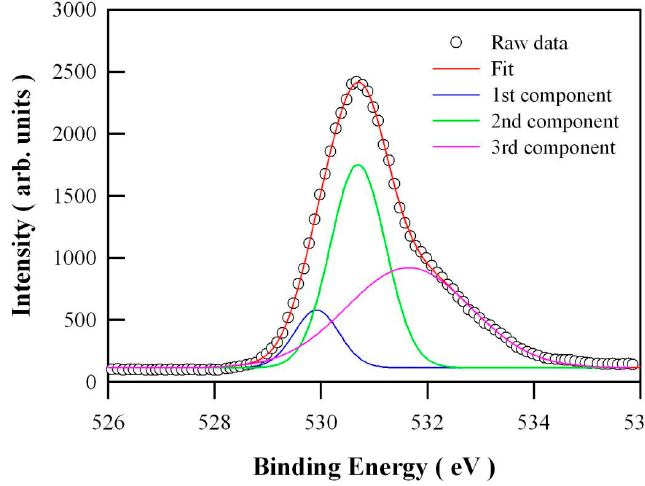
Figure 9. X-ray photoelectron spectroscopic (XPS) spectrum of O1s in undoped ZnO